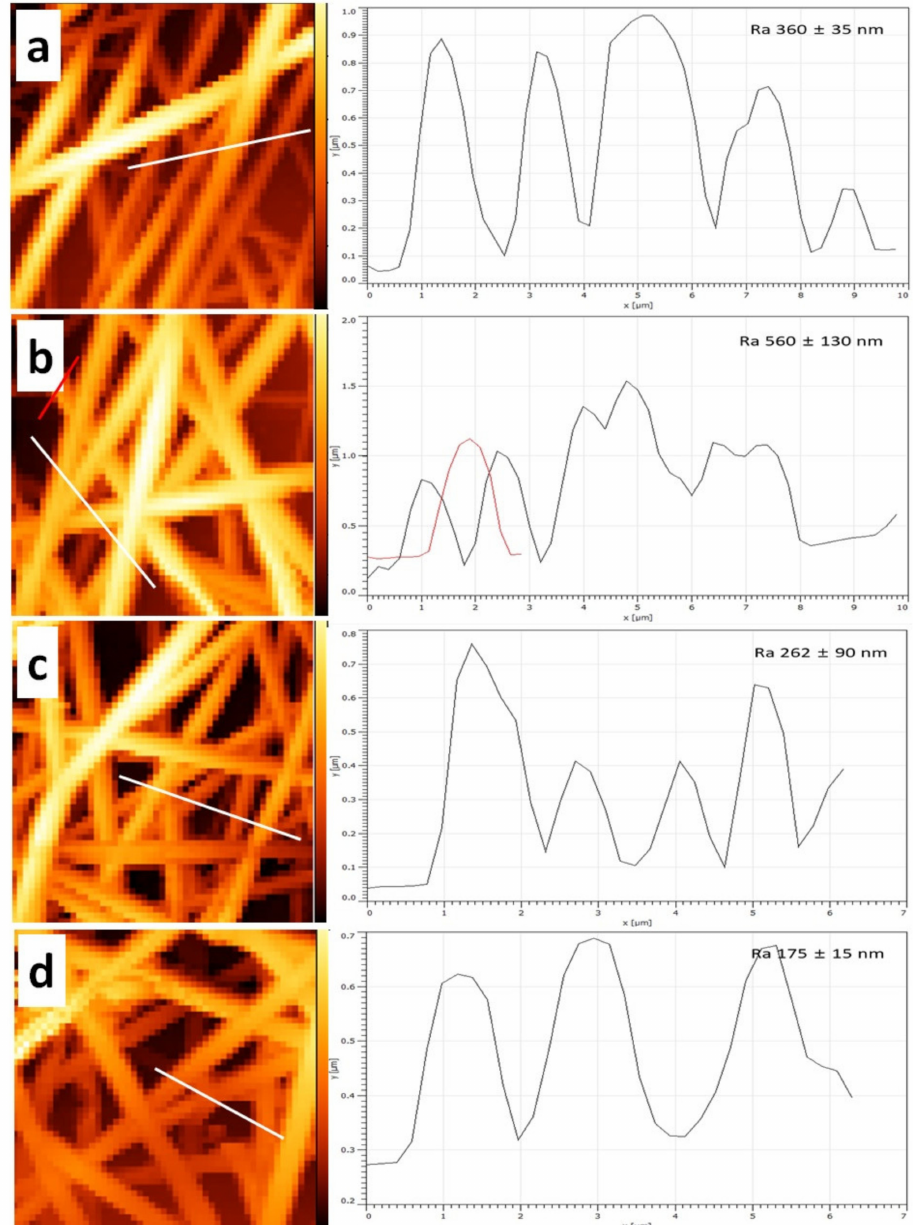
Figure 9. AFM images and the surface roughness for samples with aligned electrospun fibers ( a , b ) and samples with randomly distributed fibers ( c , d ). The inserted line (white and red) indicated the measured